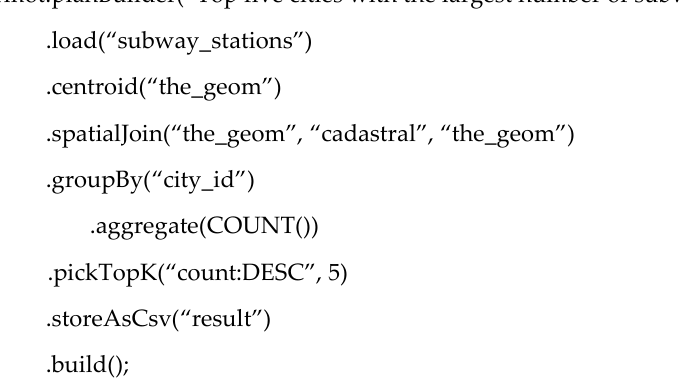
Figure 9. A Marmot code of an example Plan retrieving the top five cities with the largest number of subway stations.